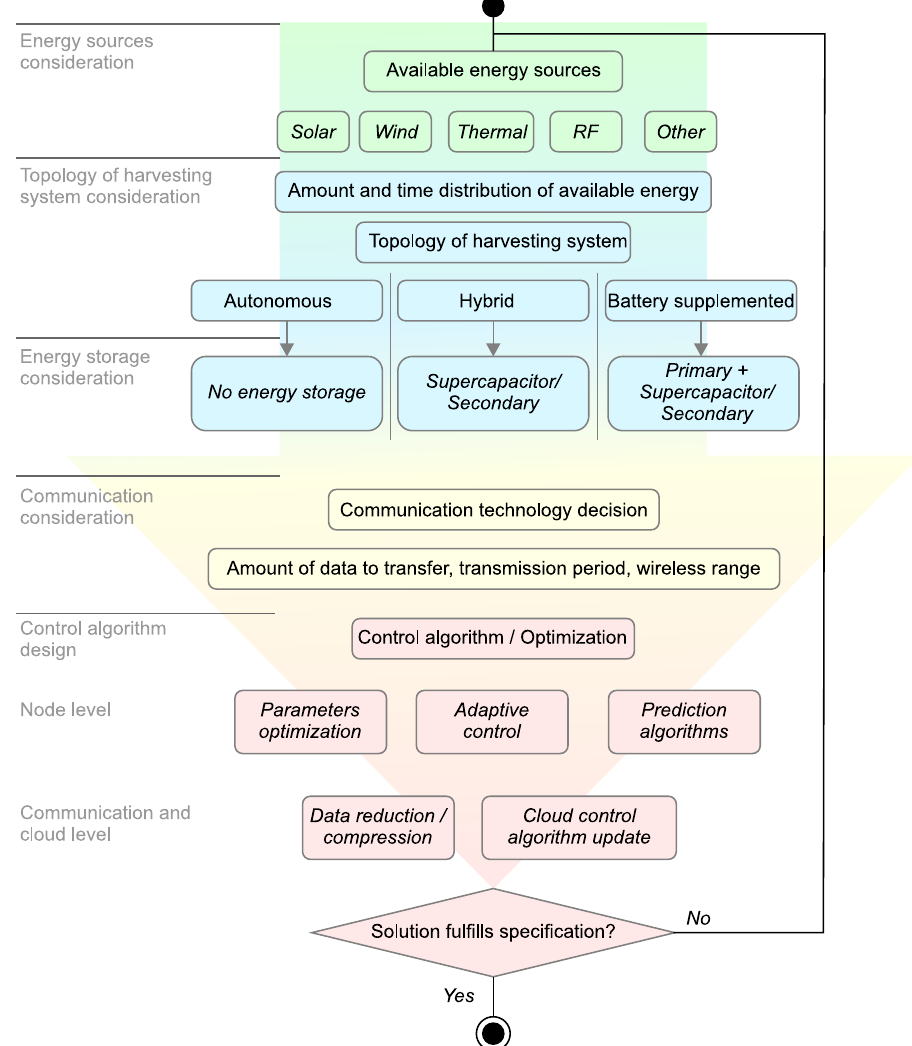
Figure 5. Flowchart of environmental wireless sensor network (EWSN) design